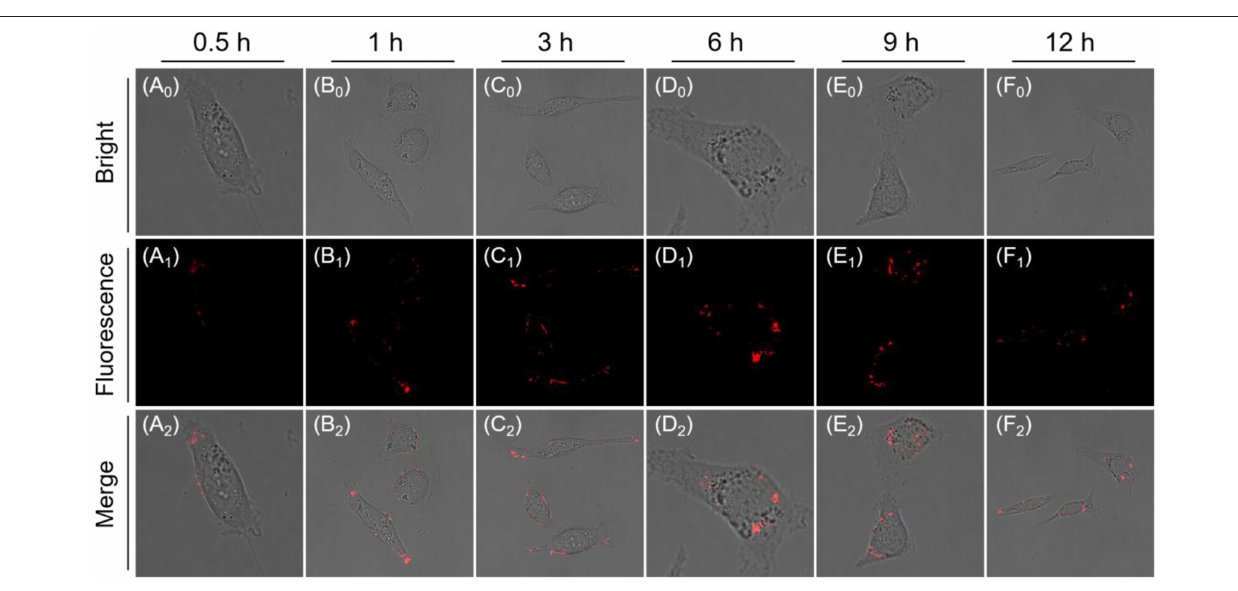
Frontiers in Chemistry |